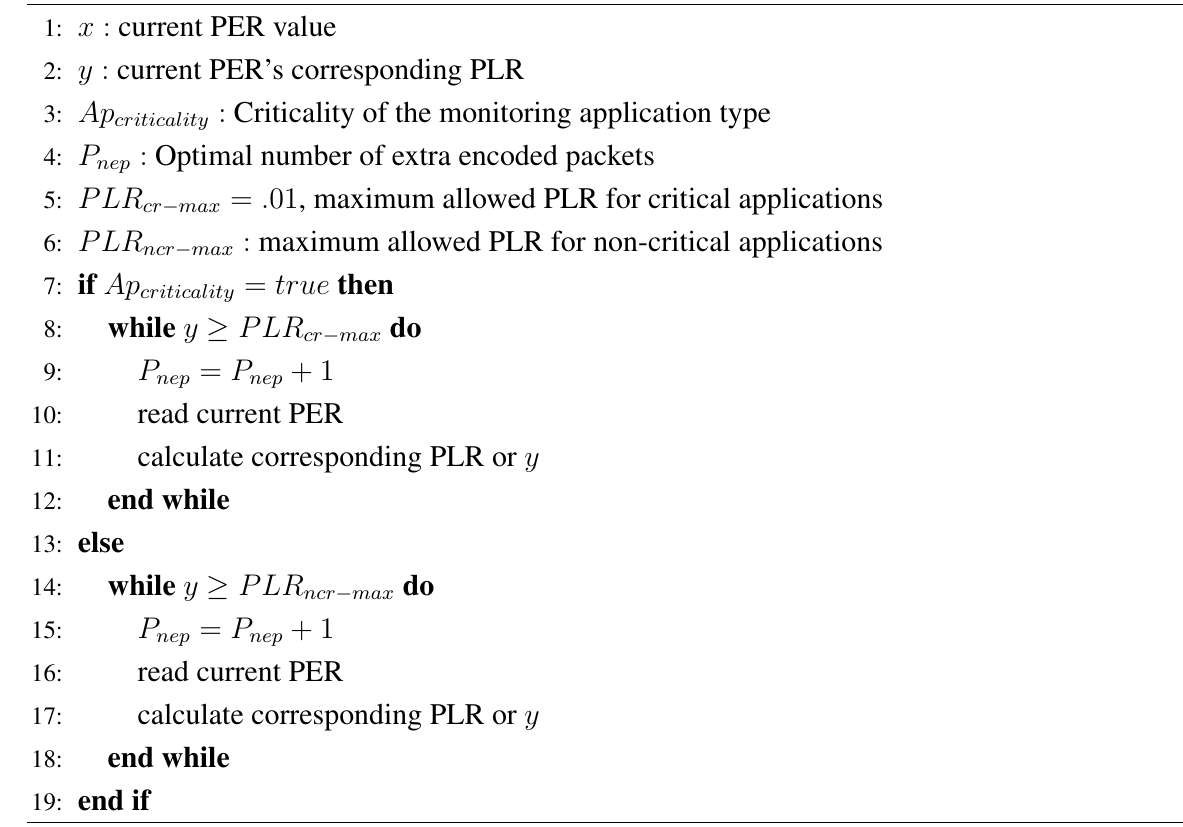
Algorithm 1 : Network’s channel condition and sensor priority-based adaptive